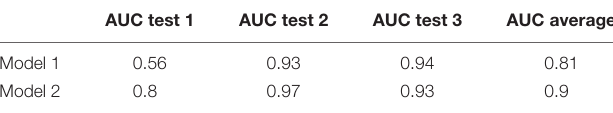
TABLE 2 | Comparative study of the AUC test data of two different models, one taking into account only the geomorphological variables (Model 1), and the other that also includes the physicochemical variables of currents and silicates (Model